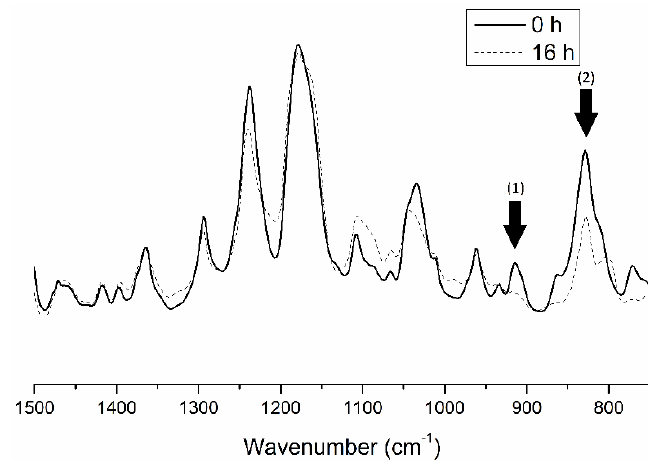
Figure 2. Infrared spectrum of the sample 5050DDM before and after curing for 16 h at 100 °C .